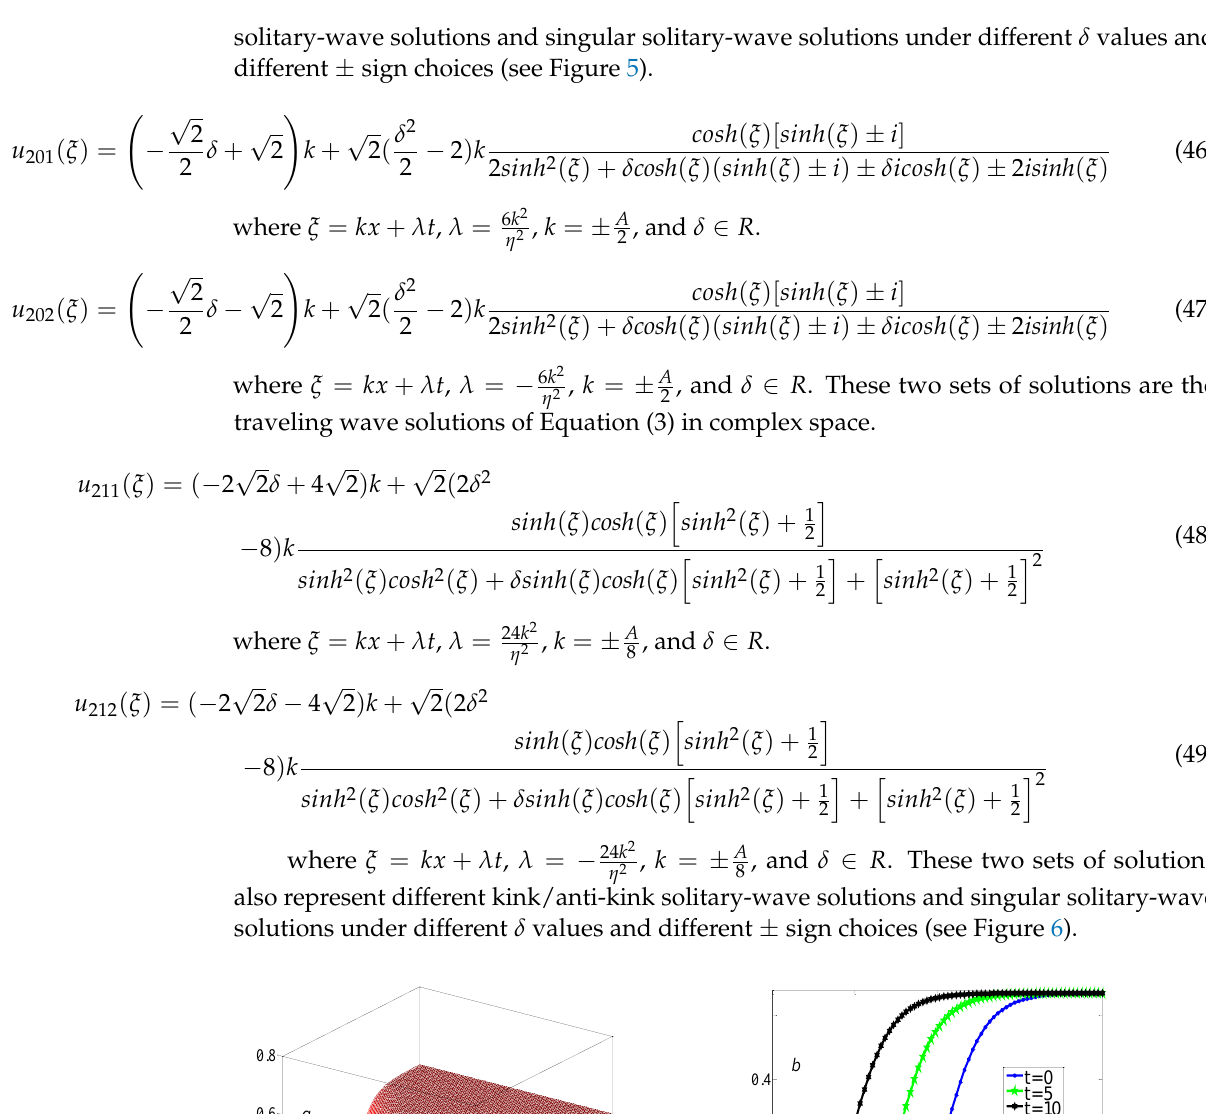
where 𝜉 = 𝑘𝑥 + 𝜆𝑡 , 𝜆 =